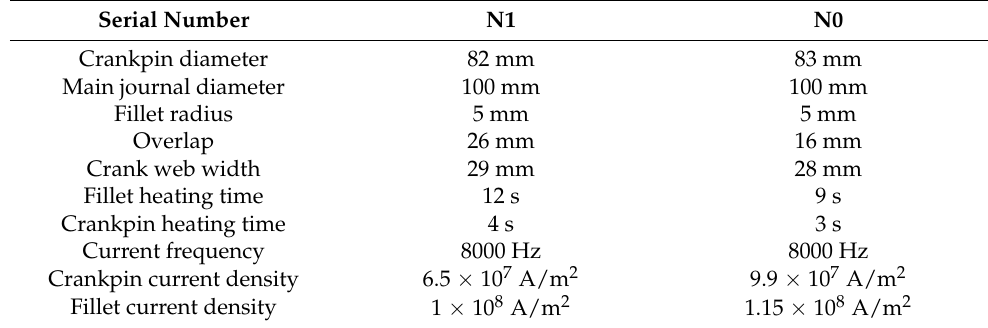
Table 2. Structure and processing parameters of both